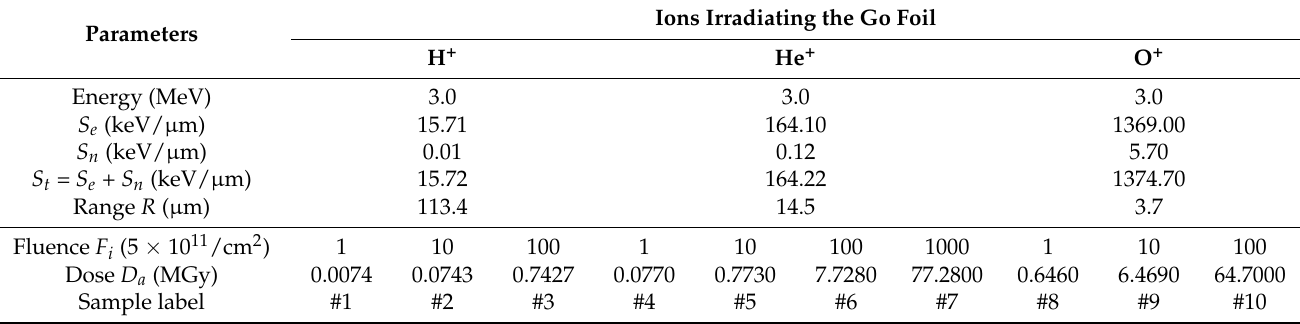
Table 4. List of experimental parameters adopted for the ion irradiation of GO foils in